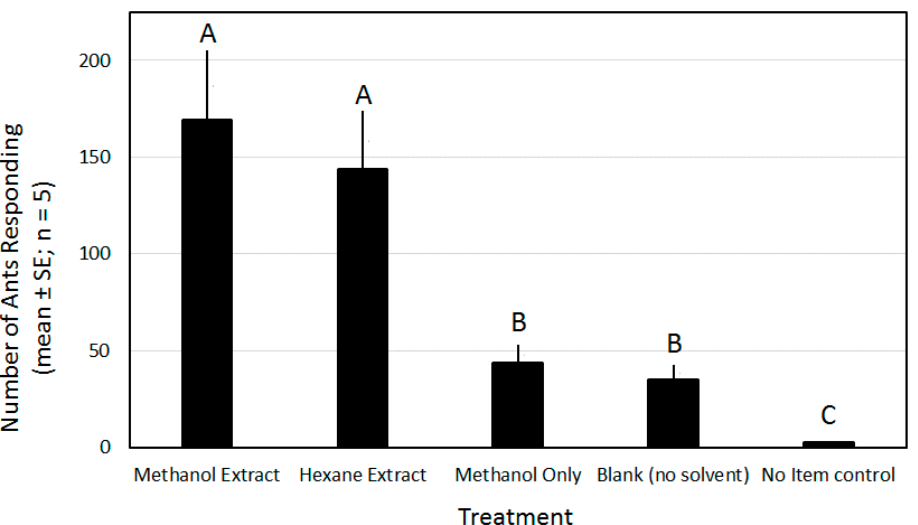
Figure 3. Number of Argentine ant workers (mean ± standard error (SE); n = 5 replicates per mean) surrounding a paper wick, with or without a pupal extract, placed in the center of a 30 mm diameter circle on the floor of a small, glass test arena. Means followed by the same letter are not significantly different [32].